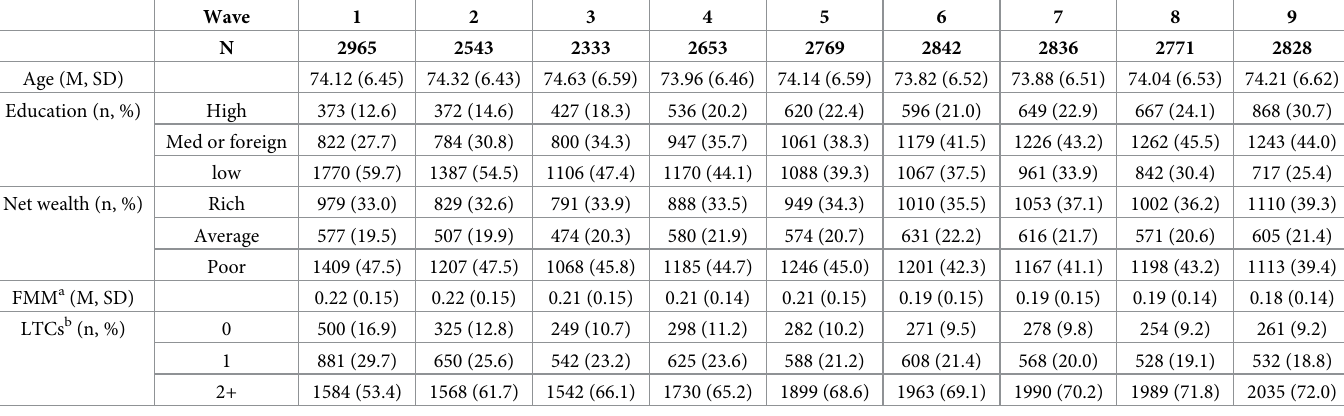
Table 2. Summary statistics for five determinants and FMM for females across the nine waves.